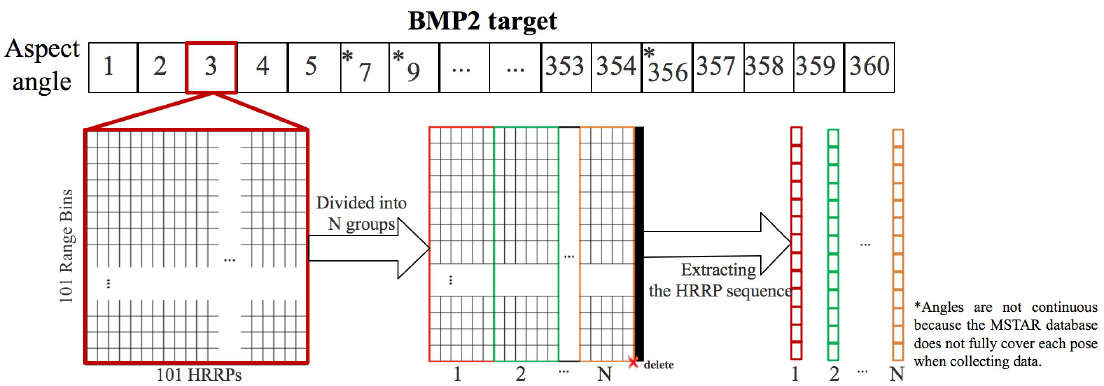
Figure 8. Extracting the HRRP sequence.